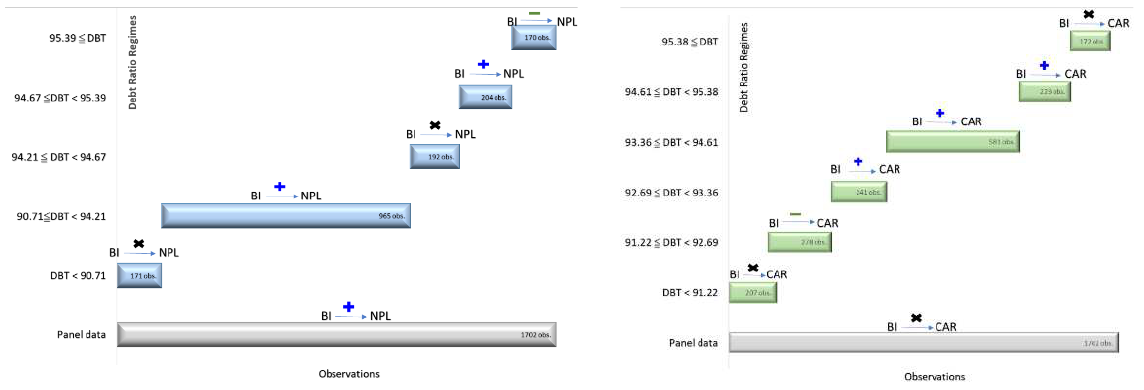
Figure 3. Nonlinear vs. linear relationship between BI and CAR, BI and NPL within debt ratio